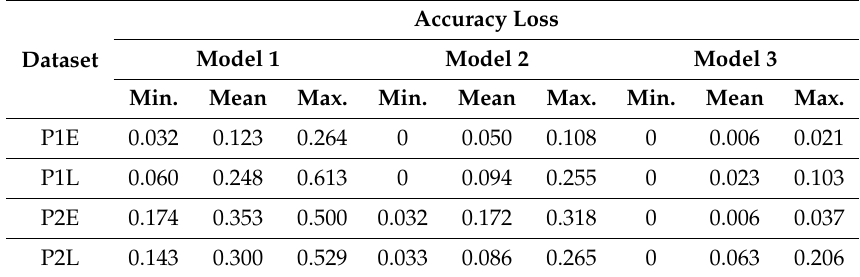
Table 3. Minimum, mean, and maximum accuracy loss rates induced by our ARIMs compared to the provided